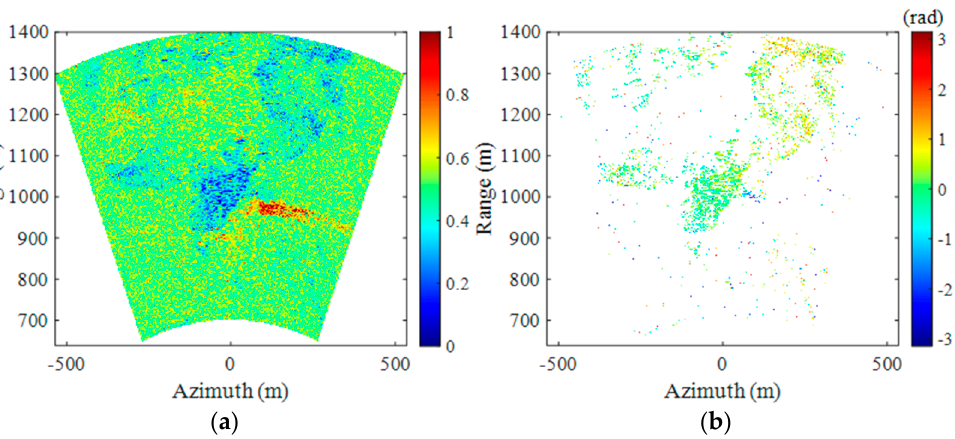
Figure 5. ( a ) The amplitude dispersion index map; ( b ) permanent scatterer phase map. Based on the differential interferometry technique, GB-InSAR images were processed together. Figure 6 shows the cumulative deformation map. Three regions with large deformations can be observed, where negative deformation indicates that the direction is toward the radar. Figure 7 shows the deformation curves of three typical points during three monitoring periods.